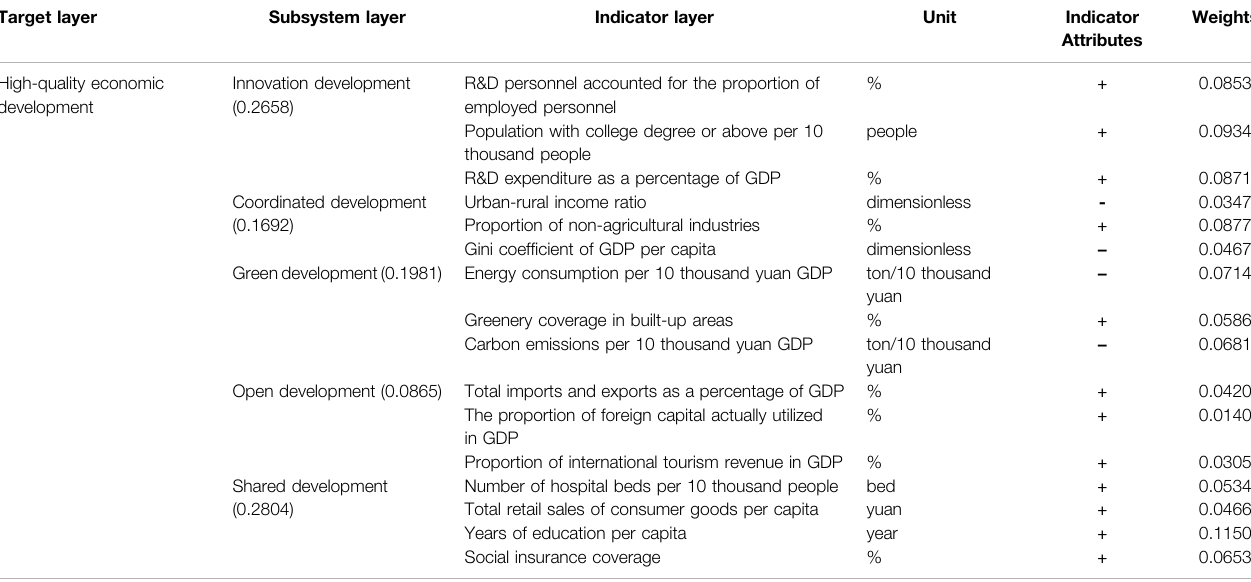
TABLE 1 | High-quality economic development index system in Xinjiang.